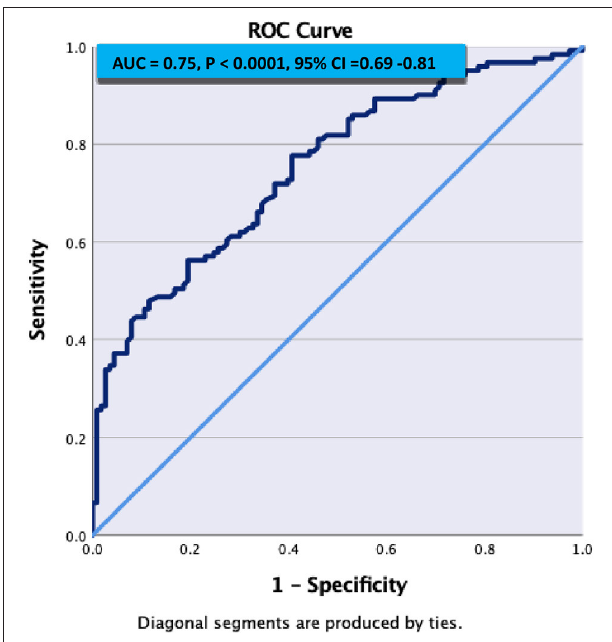
FIGURE 1 | ROC curve to predictive accuracy of SVD from the model.